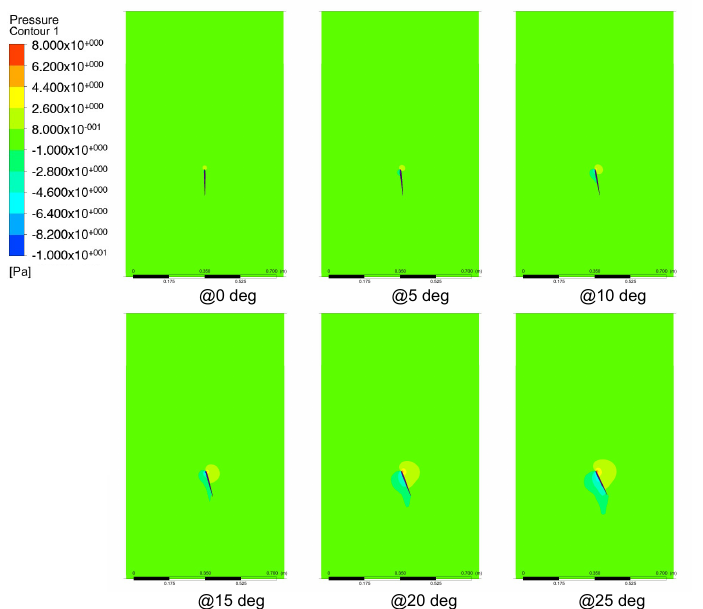
Figure 12. Pressure contours generated for an 80% MCR UAV v3.0 control-surface chord with angles of deflection from 5 to 25 degrees for Aileron 1.